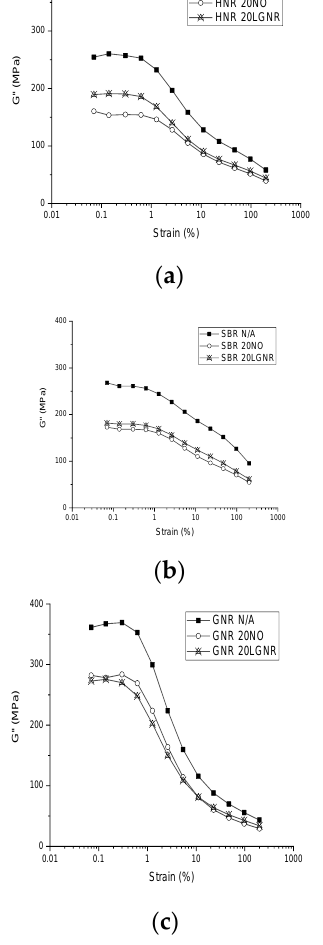
Figure 3. Loss modulus (G”) of rubber compounds with or without processing aids from 0.07% to 200% strain amplitude: ( a ) Hevea natural rubber (HNR); ( b ) styrene butadiene rubber (SBR); ( c ) guayule natural rubber (GNR). N/A: rubber compounds without processing aids; 20 NO: rubber compounds with 20 phr naphthenic oil; 20 LGNR: rubber compounds with 20 phr liquid guayule natural rubber.